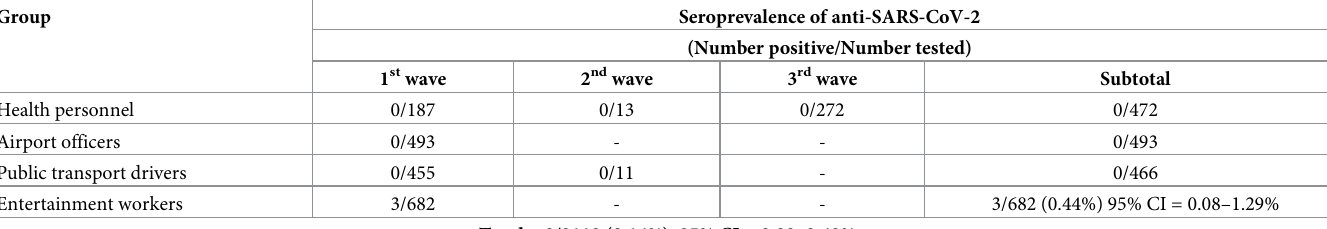
Table 2. Seroprevalence of anti-SARS-CoV-2 antibodies in participants with at-risk occupations.